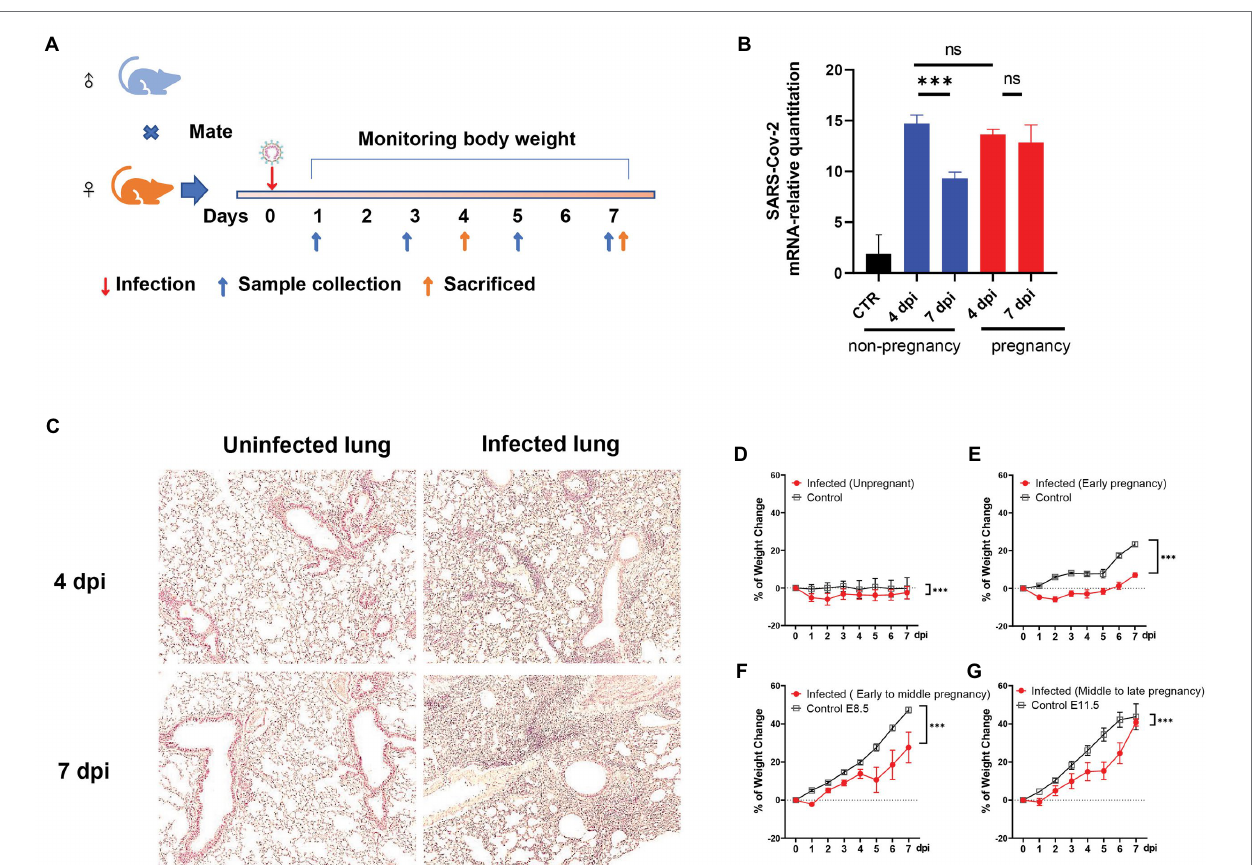
FIGURE 1 | The establishment of the severe acute respiratory syndrome coronavirus (SARS-CoV-2) infected pregnant mice model. (A) The protocol of experiments. (B) The mRNA-relative quantitation of SARS-CoV-2 N expression in pulmonary tissues showed the difference in virus load between non-pregnant and pregnant during 4–7 days post-infection (dpi). CTR, control. (C) The pathological changes of the infected lung in hematoxylin and eosin (HE). (D–G) Weight changes. After being infected by virus or mock, the weights of the mice were recorded up to 7 dpi. Data were expressed as a percent of change from the baseline body weight (X ± SE, D ) n = 13 for infected unpregnant, n = 25 for mock control; (E) n = 5 for infected (Early pregnant, started from E3.5 ± 1), n = 5 for pregnant control; (F) n = 8 for infected (Early to middle pregnant, started from E7.5 ± 1), n = 5 for pregnant control; and (G) n = 6 for infected (middle to late pregnant, started from E12.5 ± 1), n = 6 for pregnant control. Two-way ANOVA was used for time-related curve data here, while the Unpaired t -test or Mann-Whitney test was used for two groups compare. ns p > 0.05, *** p <